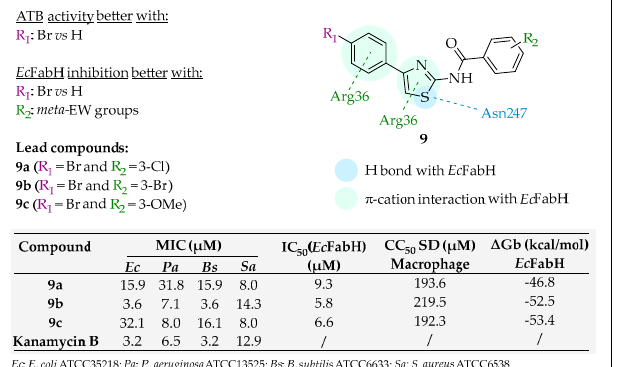
Figure 10. Structure, SAR and representation of main interactions with Ec FabH of thiazole derivatives 9 and in vitro activities and ∆ Gb of lead compounds [81].